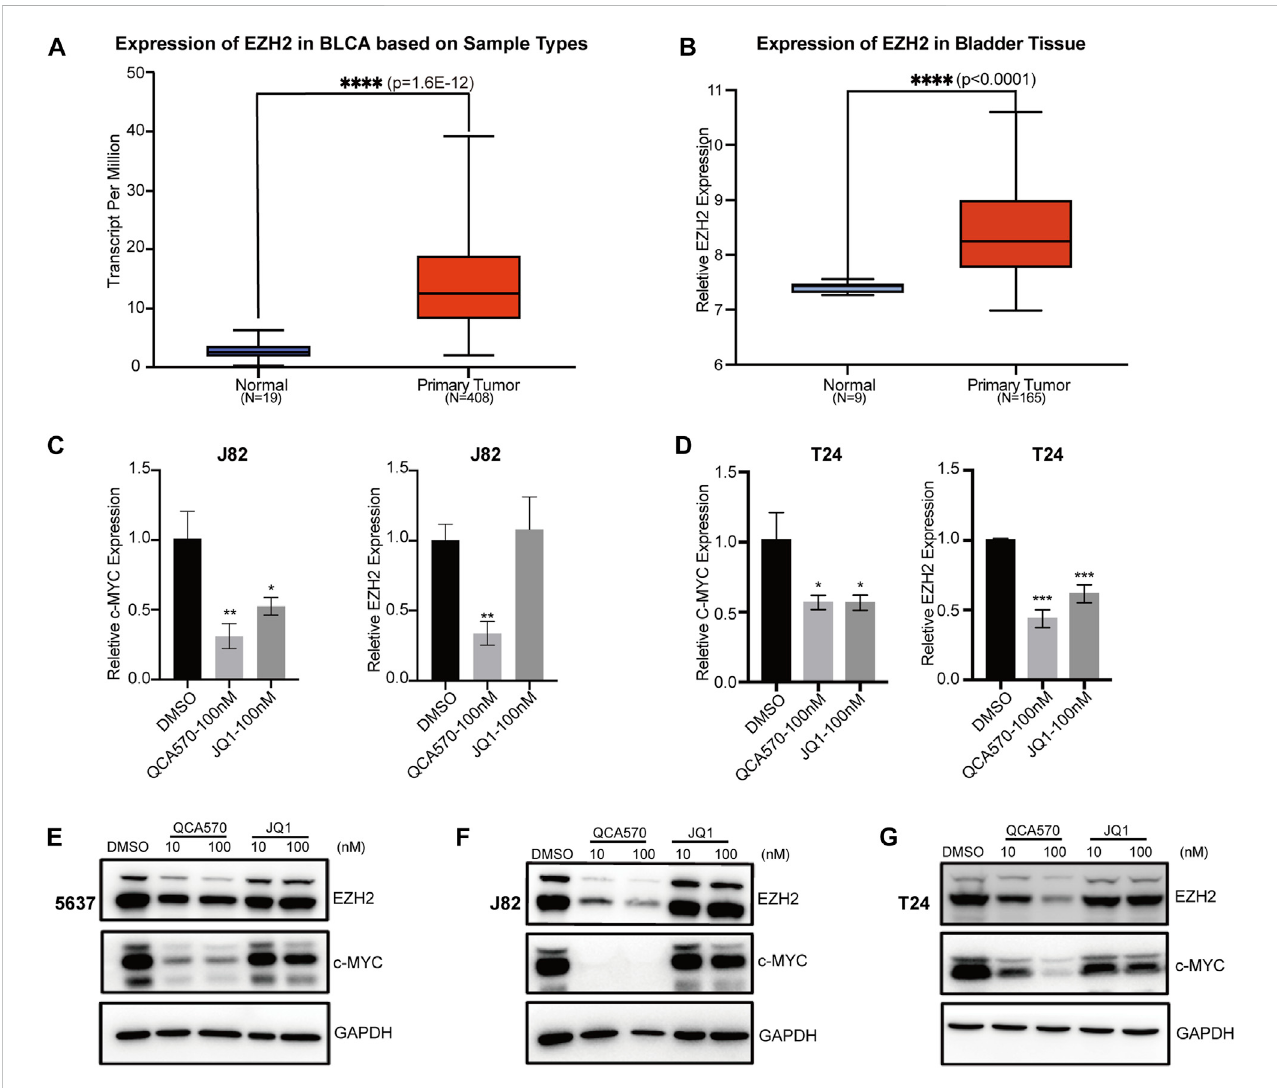
FIGURE 3 BRD4 target genes are downregulated by QCA570 (A) The EZH2 mRNA expression level of bladder tissues was analyzed in TGCA cohorts. The p -value was examined by the Mann – Whitney U-test. (B) The relative expression level of EZH2 was determined in GEO database (GSE13507). Using the remove Batch Effect function in the limma package to removes batches. The p -value was examined by Welch ’ s t -test. (C, D) RT-qPCR analysis of c-MYC and EZH2 gene expression in J82 and T24 cells. Values are the means ± SEM, * p < 0.05, ** p < 0.01, *** p < 0.001, two-tailed Student ’ s t-test. (E – G) The protein level of c-MYC and EZH2 were detected by Western blotting. GAPDH was used as loading